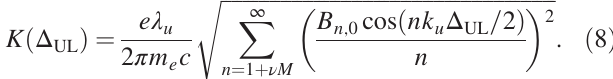
FIG. 1. Halbach arrays with the relative longitudinal displacement between the upper and lower magnet arrays Δ = 4 , (c) þ λ = 2 , and (d) − λ = 4 . The pair of small arrows indicates the attractive (blue) or repulsive (red) force between two (b) þ λ u u u magnets. The total forces acting on the magnet beam are drawn by the large arrows (white). The phase diagram of the forces and the peak fields are drawn in